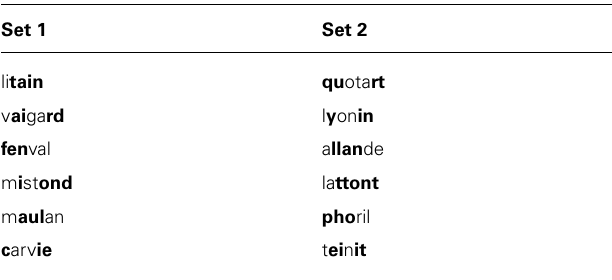
Table 1 | Pseudo-word sets (inconsistent phoneme-grapheme correspondences in